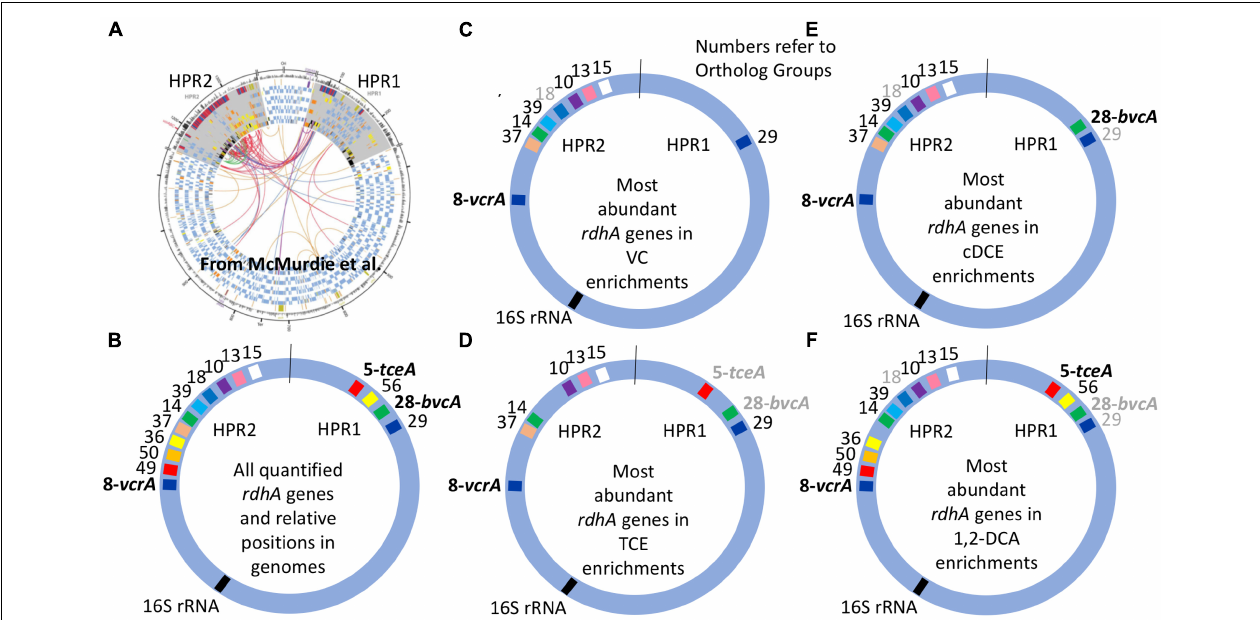
FIGURE 3 | Distribution of most abundant D. Mccartyi reductive dehalogenase homologous ( rdhA ) genes quantified in KB-1 enrichment cultures. RdhA sequences are represented by their corresponding ortholog group (OG) numbers and relative positions in High Plasticity Regions (HPR) 1 and 2, as defined by McMurdie et al. (2009).) (A) Circular map of four Dehalococcoides genomes reproduced from McMurdie et al. (2009), illustrating the two high plasticity regions where most rdhA genes are found; origin is at top. (B) Relative position of all of the rdhA sequences quantified by qPCR in this study. (C–F) Most abundant rdhA genes detected in the respective enrichment culture samples, with evidence for considerable strain variation within and between enrichment cultures. OG numbers that are gray correspond to genes that are abundant in only some of the samples from the respective enrichments. See Supplementary Table S3 or Figure 1 for correspondence between OG and KB-1 rdhA